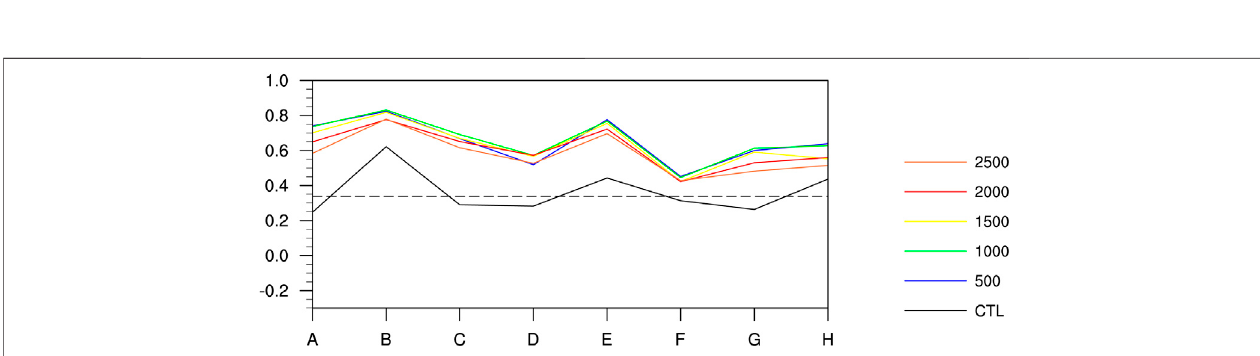
FIGURE8| Correlationcoef fi cient(CC)ofsimulated2 mrelativehumiditywithnudgingallvariablesunderdifferentcutoffwavelengths(blackdashedlineindicatesa CC threshold of 0.1% signi fi cance based on a t-test).